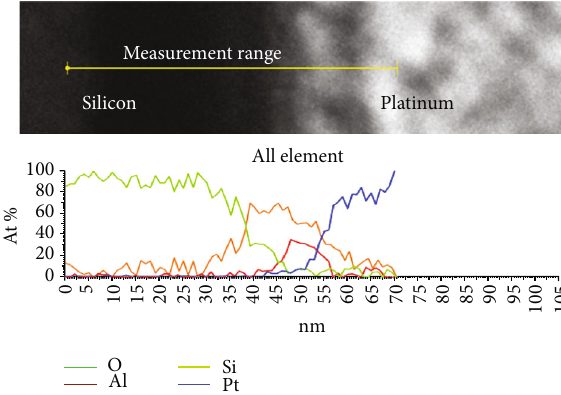
O /SiO /Si stack after the aluminum 2 3 2